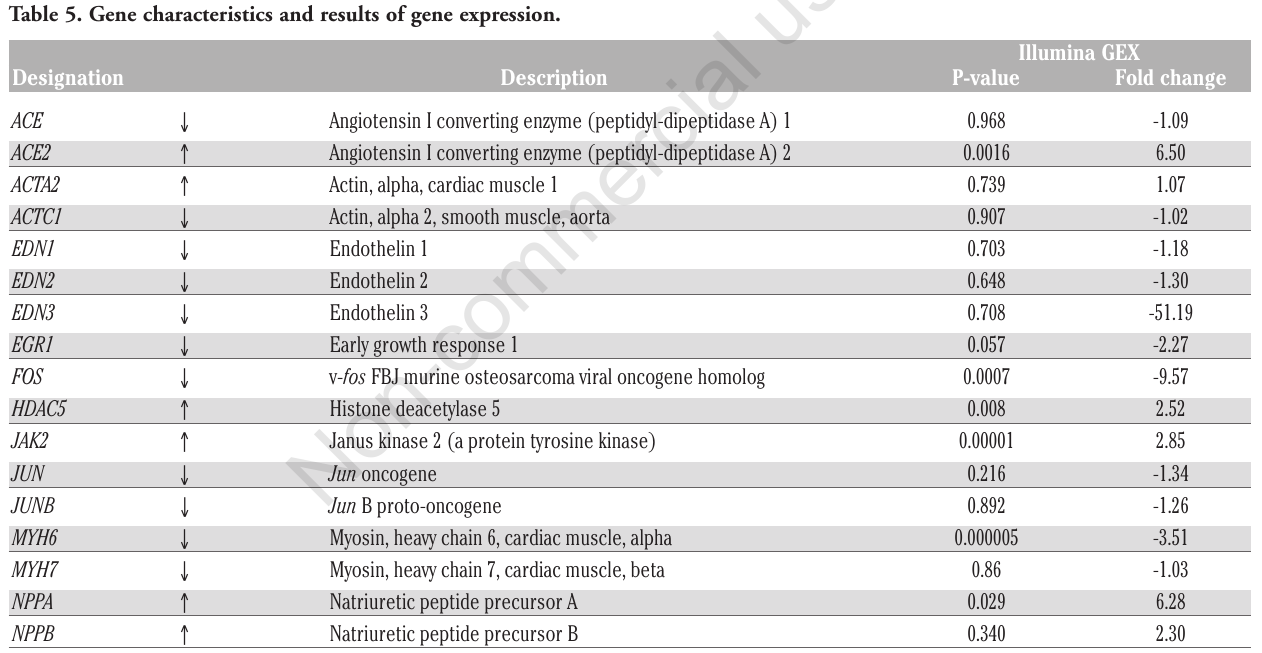
Table 5. Gene characteristics and results of gene expression.